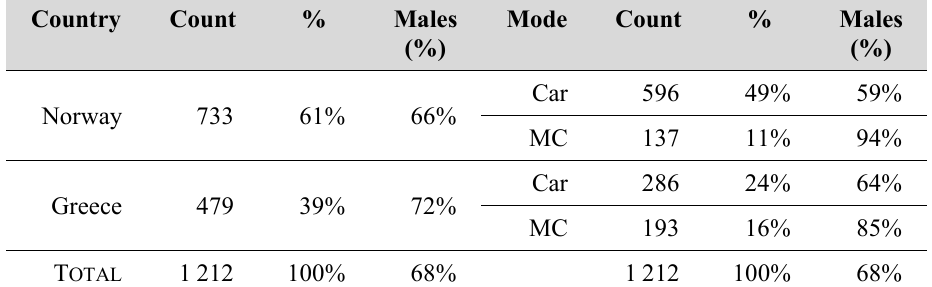
Table 1 Distribution of drivers/riders in Norway and Greece, including the proportion of males Country Count % Males Mode Count % Males (%) (%) Car 596 49% 59% Norway 733 61% 66% MC 137 11% 94% Car 286 24% 64% Greece 479 39% 72% MC 193 16% 85% T OTAL 1 212 100% 68% 1 212 100%